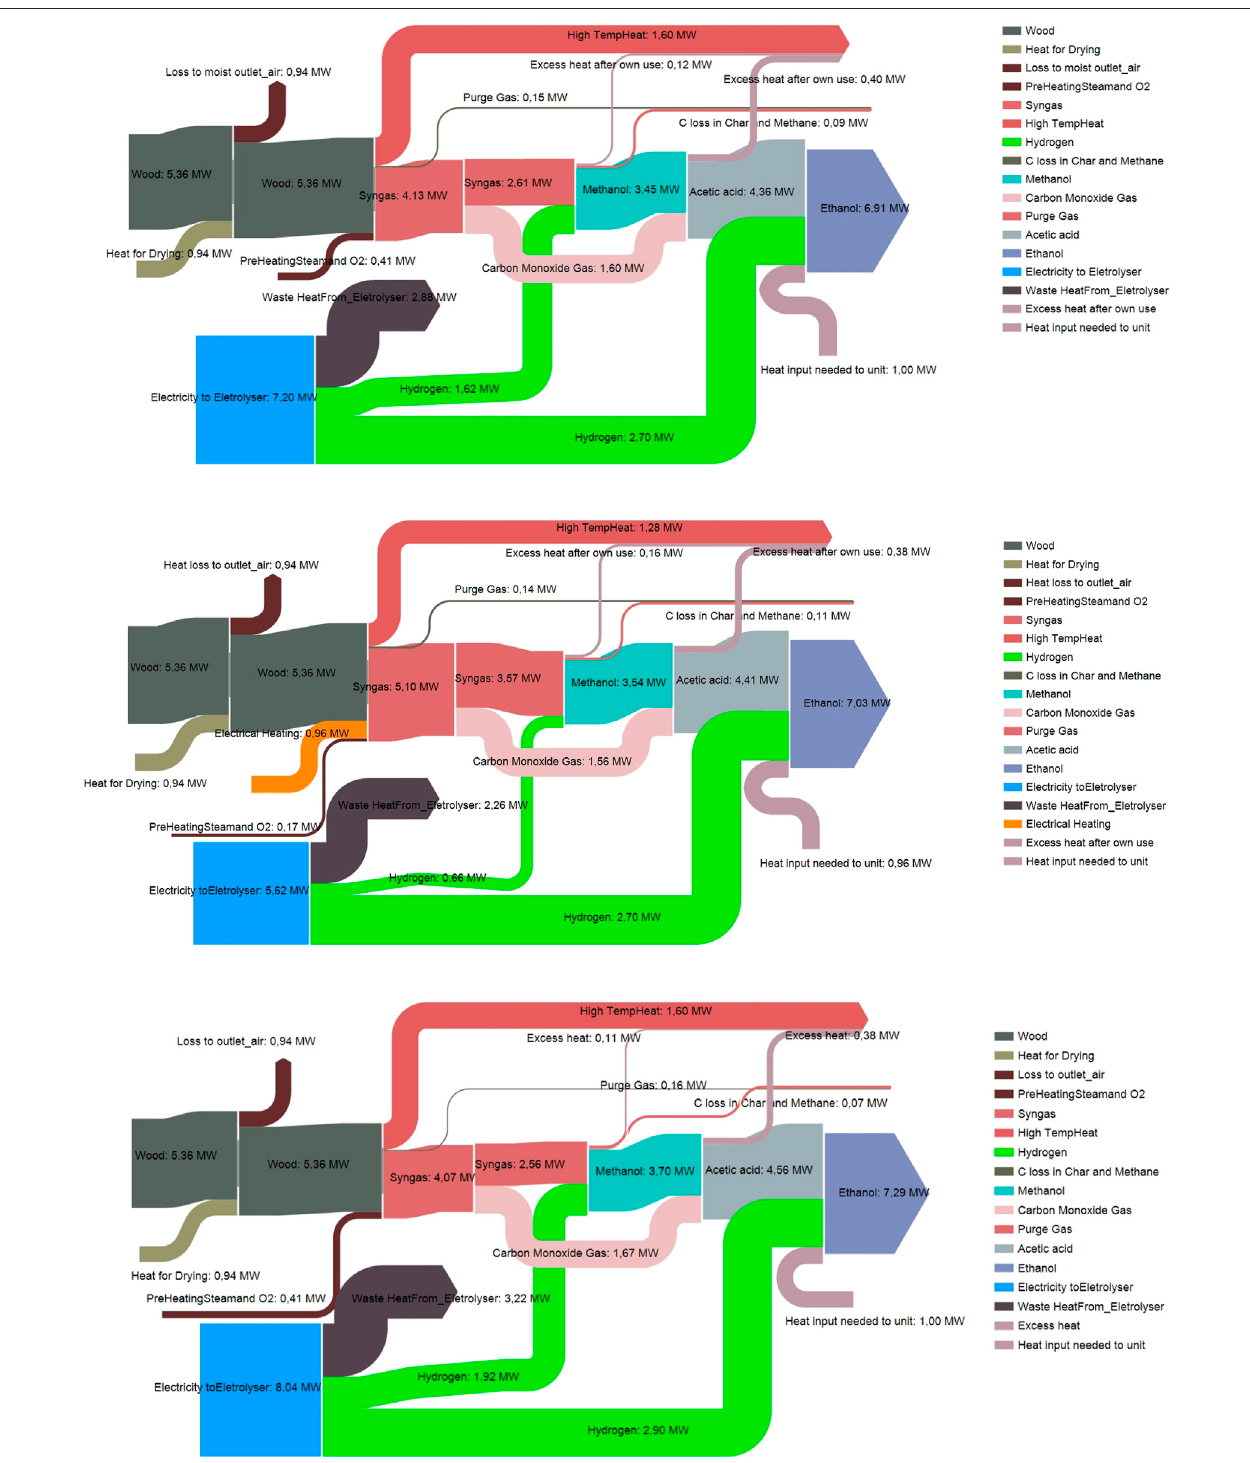
FIGURE 6 | Sankey diagram illustrating energy fl ows and losses for case A-C.